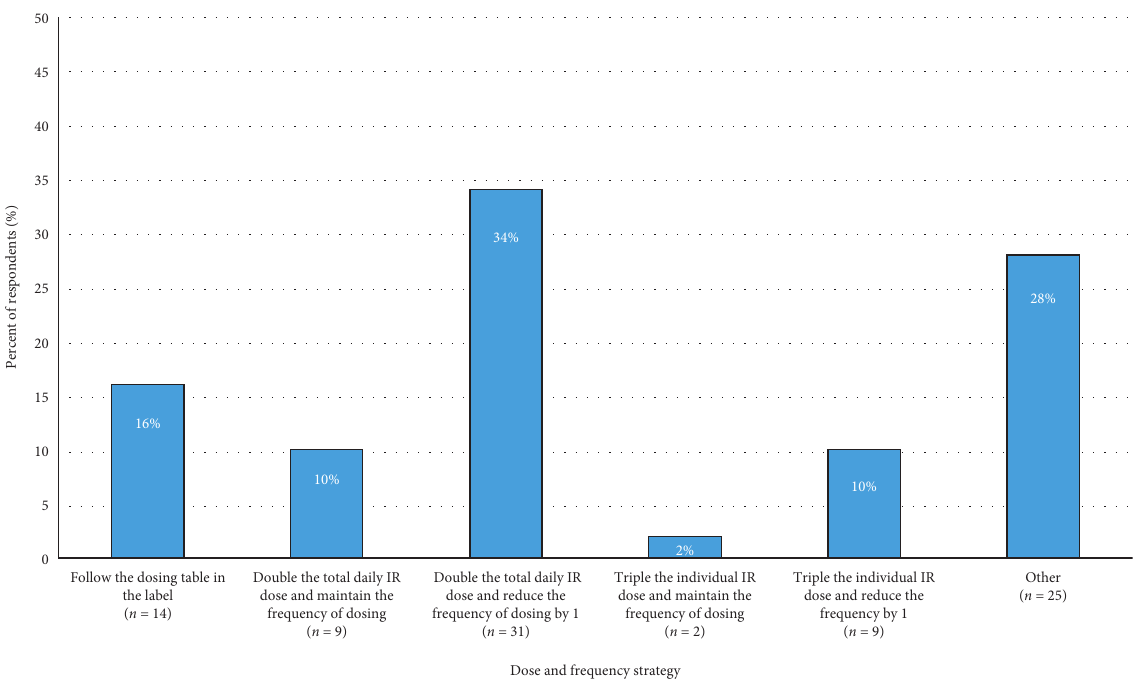
Figure 2: Recommended dosing and frequency strategy ( N � 90).